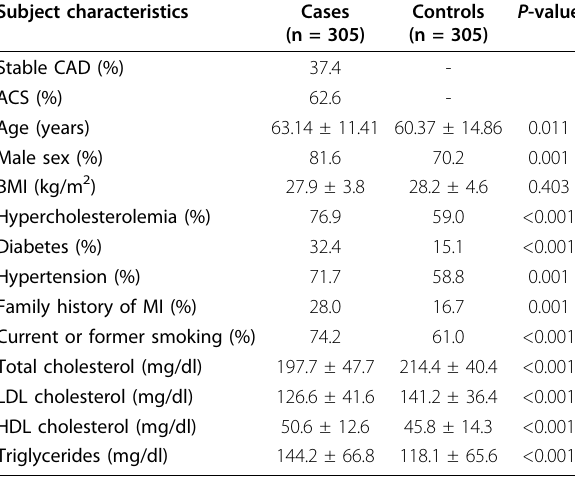
Table 2 General characteristics of patients and controls included in our